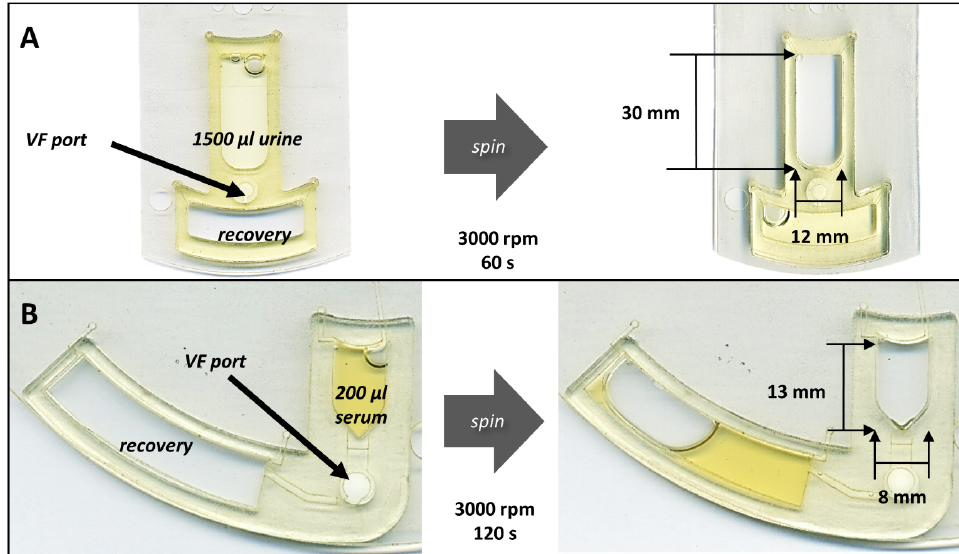
Figure 5. On-disc flowthrough of large volume body fluid samples. ( A ) The cOF disc was redesigned with 4 mm OF port (same radial distance from CoR) and larger chambers, i.e., thicker 1.5 mm PMMA accessory pieces were affixed to the top and bottom of the disc. At 3000 rpm, this cOF design was able to process 1.2 mL of assay buffer (~3 min). Likewise, at 3000 rpm this design processed 1.5 mL of neat urine (<60 s). The bulk fluid was removed from the recovery chamber and two additional 1.5 mL aliquots of urine were passed through the same cOF membrane (total urine volume = 4.5 mL). ( B ) The cOF disc was redesigned with a 4 mm OF port (same radial distance from CoR) and a larger waste chamber. At 3000 rpm, this cOF design processed 200 μ L of human serum in ~120 s. Three additional aliquots of serum (200 µ L ea) were passed through the same membrane (total serum volume = 800 µ L).